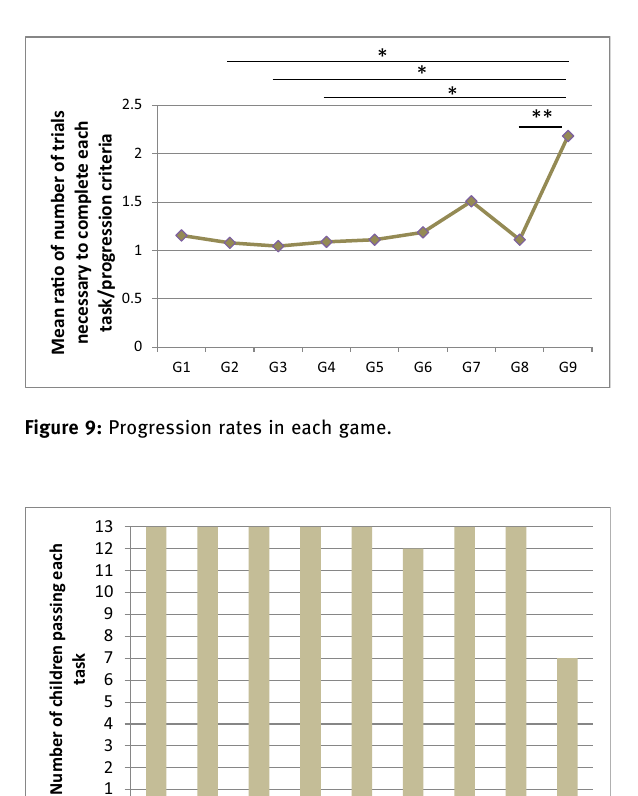
Figure 8: Participants ’ pre - and post - test performance in the Charlie